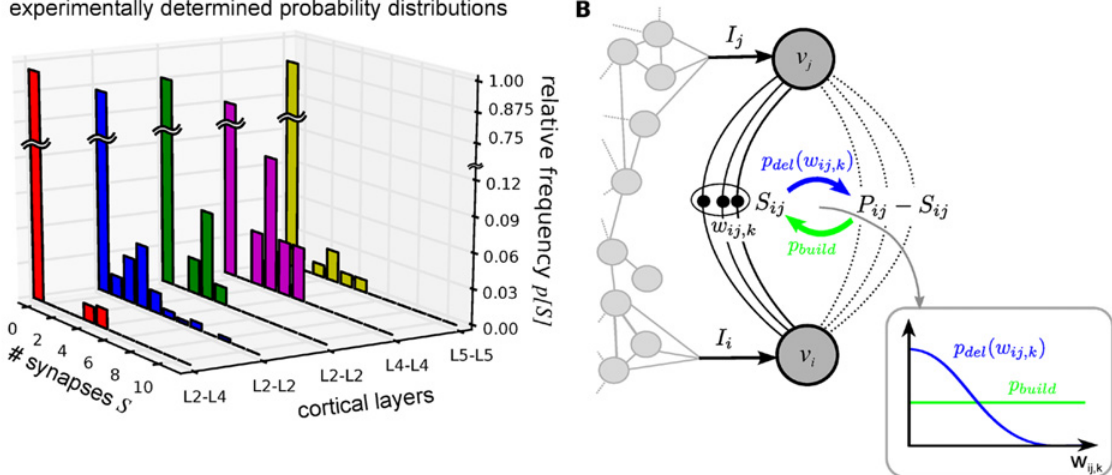
Figure 1. Experimentally obtained distributions of the number of synapses on a single connection and the here proposed structural plasticity model. (A) The relative frequencies p [ S ] of the number of synapses between two neurons obtained from experiments [10, 36 – 39] show strong peaks for no synapses and 3 – 8 synapses. The probability for no synapses ( S = 0) reaches from 0.75 to 0.99 (for [38] this probability was taken from [81]). (B) Scheme of the proposed structural plasticity model shows relevant quantities of the model for one connection. Synapses are created from a pool of potential synapses p S w k = 1 ... S P ij with a constant probability build . Each of the ij realised synapses has a weight ij , k ( ij ) which develops according to a synaptic plasticity rule. Synapse removal happens with a weight-dependent probability p del ( w ij , k ). All influences which do not relate to the examined neurons are modelled by currents I i or I j . Inset: An example for the weight-dependency of building and removal probabilities shows that smaller synapses are more likely to be deleted. (See main text for more details)